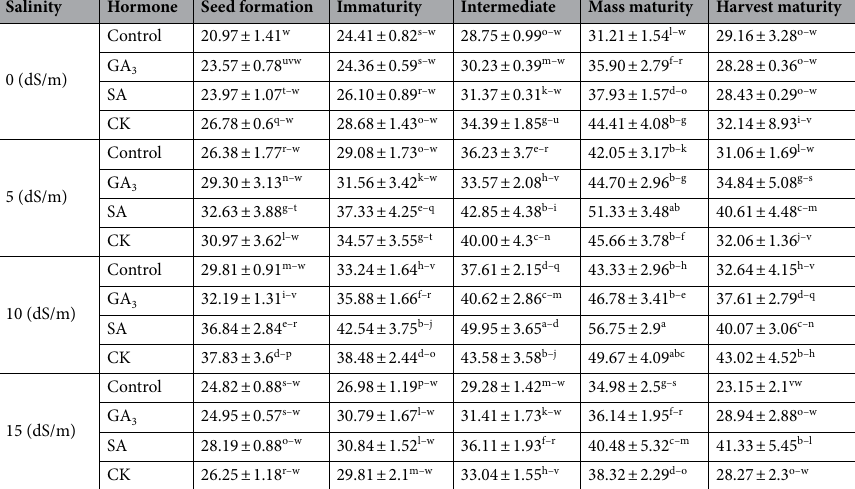
Table 2. Total phenolic content (mg GAE/g essential oil) of the essential oil from the dill seeds under different salinity and hormonal treatments at different stages of maturity. The values are the means of three replicates ± standard error. GA 3 gibberellic acid, SA salicylic acid, CK cytokinin. Different letters in each column indicate significant difference by Duncan multiple range test at p ≤